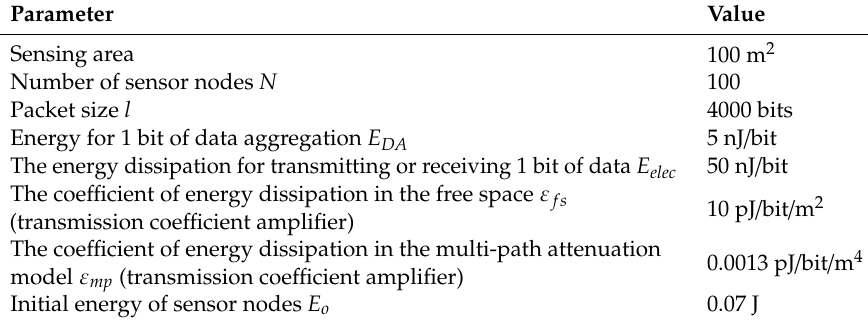
Table 1. Simulation parameters.